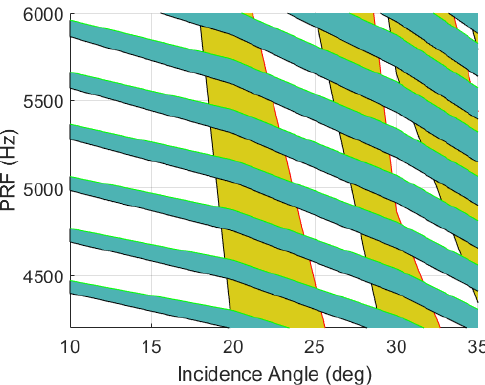
Figure 2. Dependency of usable PRFs (white area) as incidence angles vary. Unavailable PRF values due to blind ranges and nadir returns are depicted in yellow and